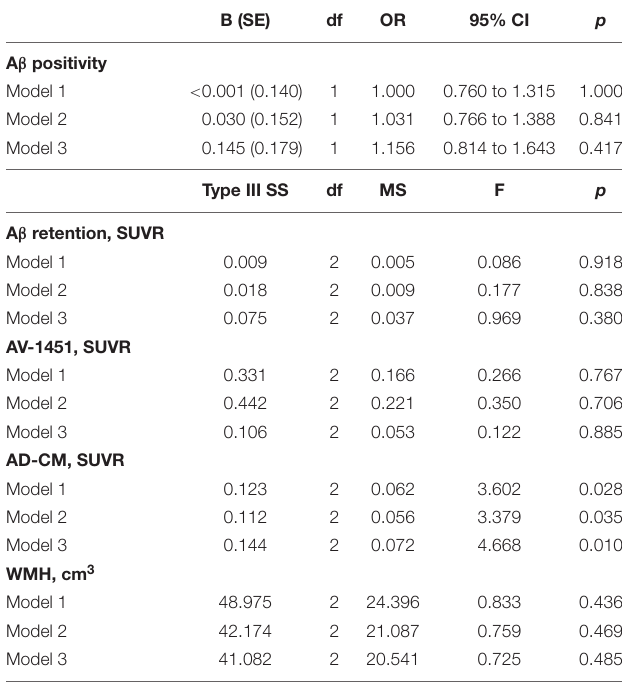
TABLE 3 | Results of multiple logistic regression and general linear model analyses for assessing the relationship between serum UA strata and A β , AV-1451, AD-CM, or WMH volume in non-demented older